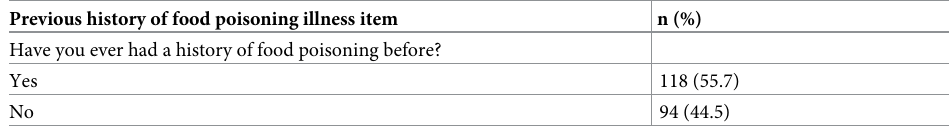
Table 4. Distribution of respondents (%) according to the previous history of food poisoning